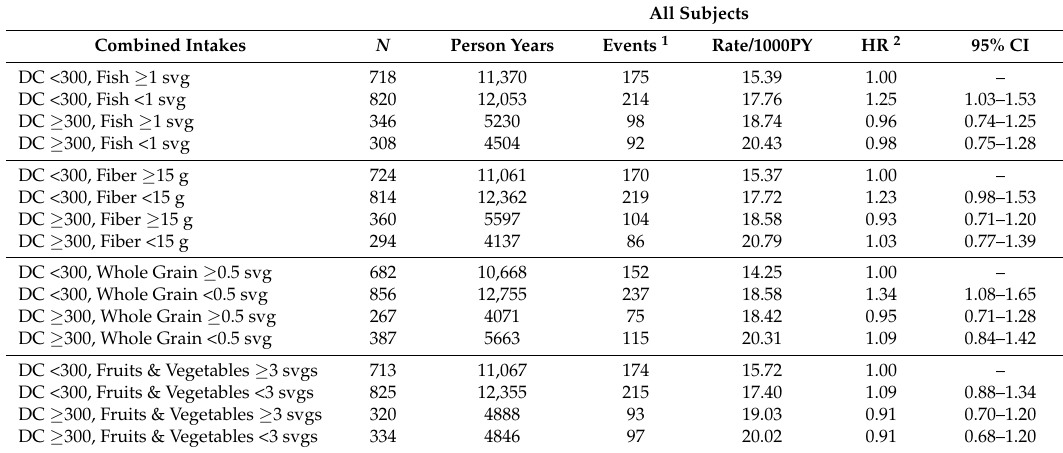
Table 3. Rates and adjusted hazard ratios for T2DM or IFG according to combined intakes of dietary cholesterol and other dietary